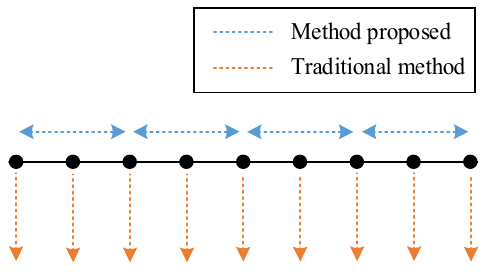
Figure 14. The difference between traditional methods and method proposed.